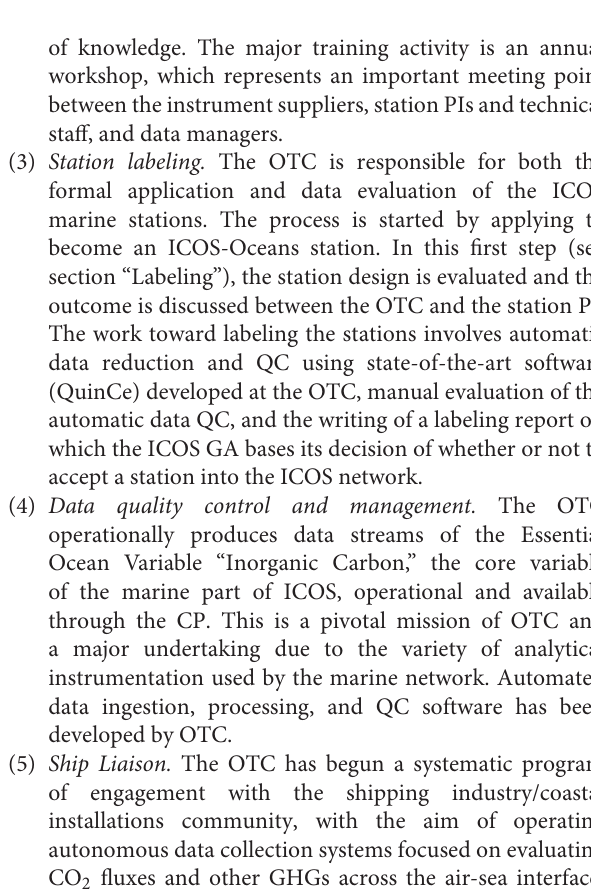
FIGURE 3 | Observational capacity and capability of ICOS in relation with the Global Ocean Observing System (GOOS) Framework for Ocean Observing process (figure was adapted from GOOS; Lindstrom et al., 2012). The black label indicates the current capability of ICOS, and the yellow the future potential (see section “Emerging